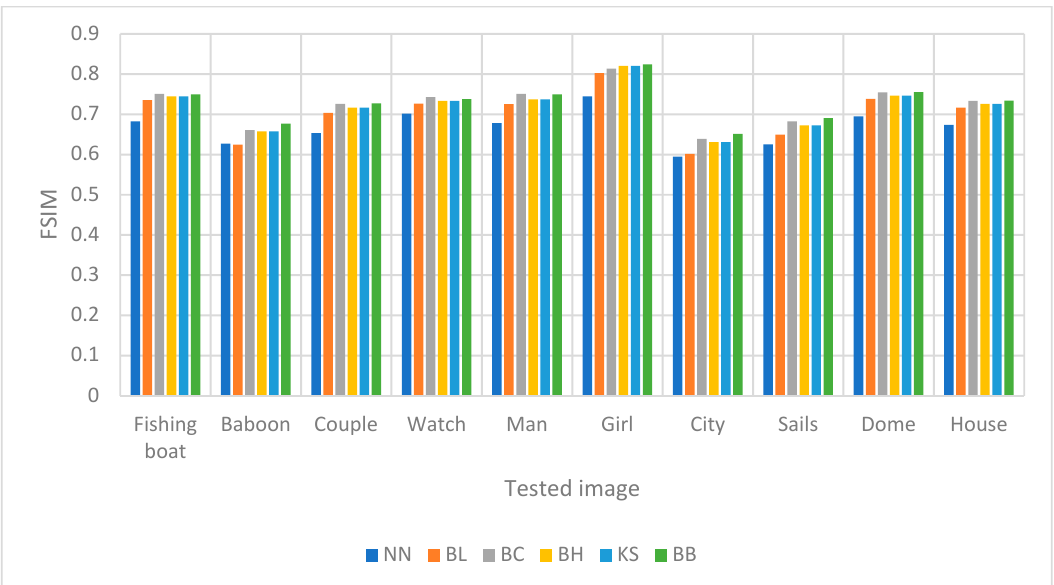
Figure 11. A comparison of schemes toward FSIM for image upscaling with a factor of four.